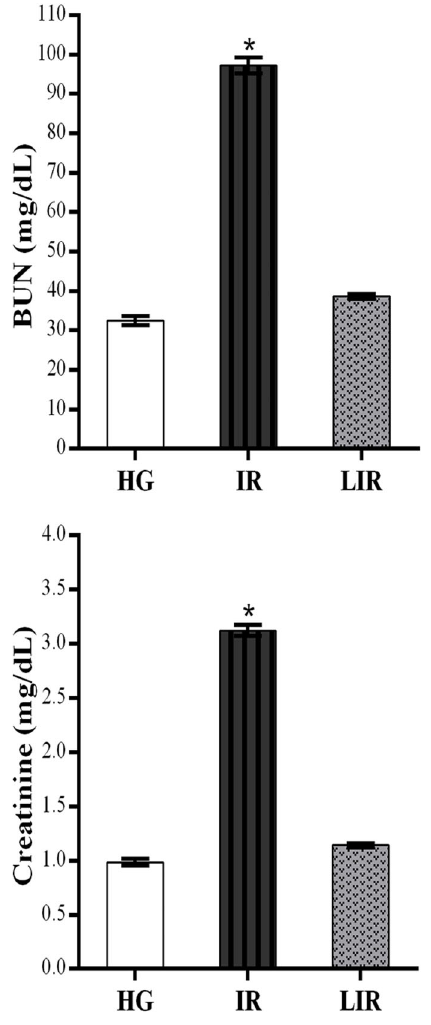
Figure 2. Total oxidant status (TOS) and total antioxidant status (TAS) levels of healthy control (HG), isoniazid + rifampicin (IR), and lycopene + isoniazid + rifampicin (LIR) groups in the kidney tissue. Data are reported as means ± SE. *P o 0.0001 compared to HG and LIR groups (n=6) (ANOVA followed by Fisher ’ s post hoc least signi fi cant differences).